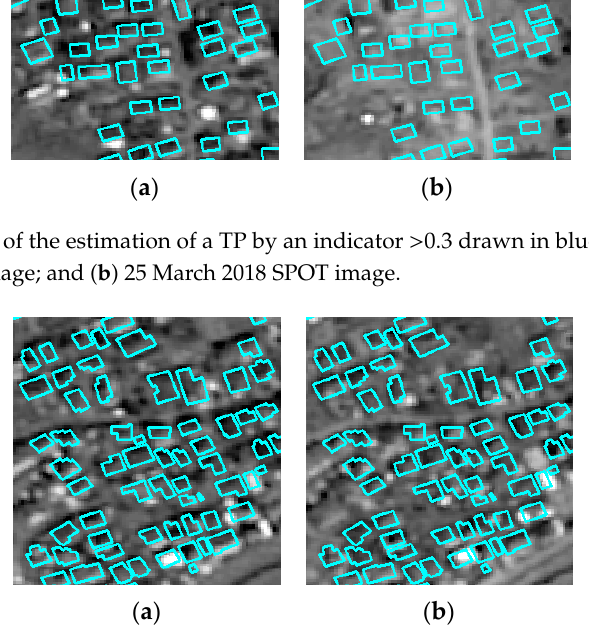
Figure 18. Examples of the wrong estimation of a FP due to anomalous bright pixels drawn in blue outline on a: ( a ) 20 March 2016 SPOT image; and ( b ) 25 March 2018 SPOT image.